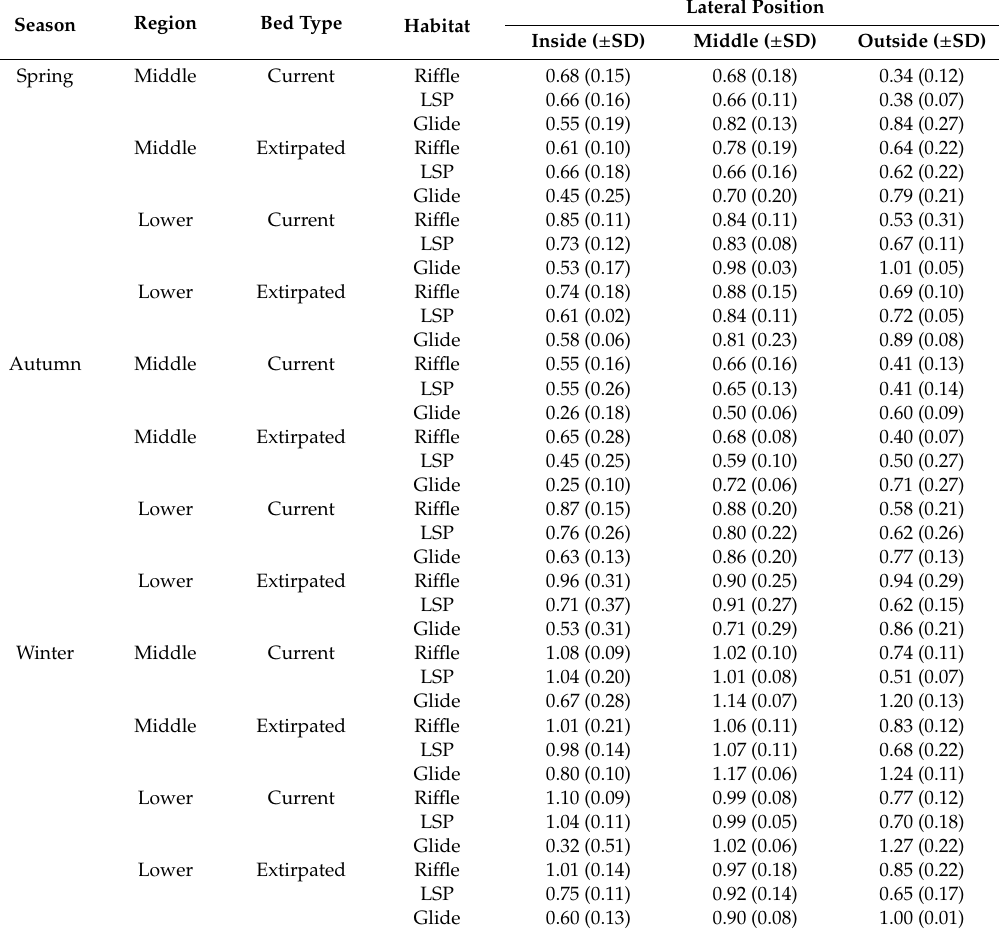
Table A1. Pooled mean velocity (m · s − 1 ; ± SD) by lateral position (Inside, Middle, Outside) across seasons (Spring, Autumn, Winter), regions (Middle, Lower), bed type (Current, Extirpated), and habitat (Ri ffl e, LSP,